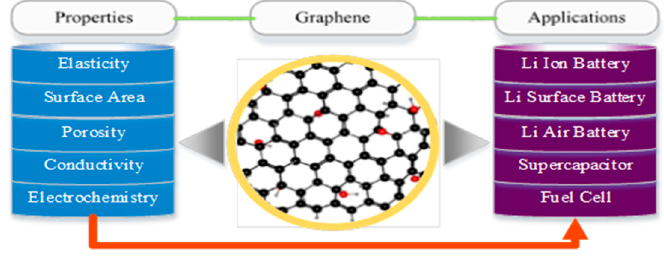
Figure 3. Applications of graphene with unique properties.